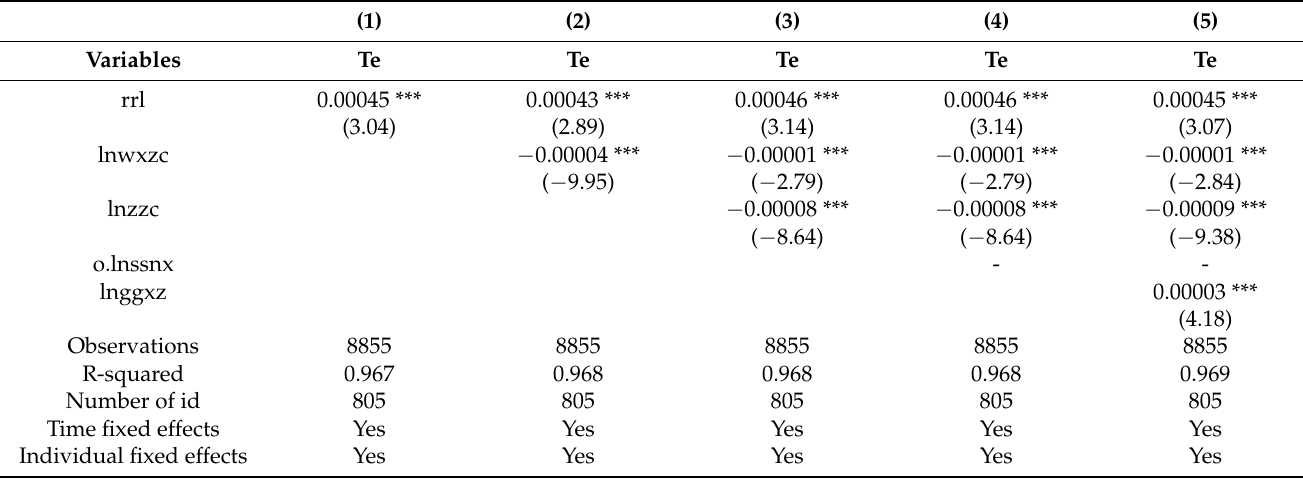
Table 8. Baseline regression results based on IV estimation.